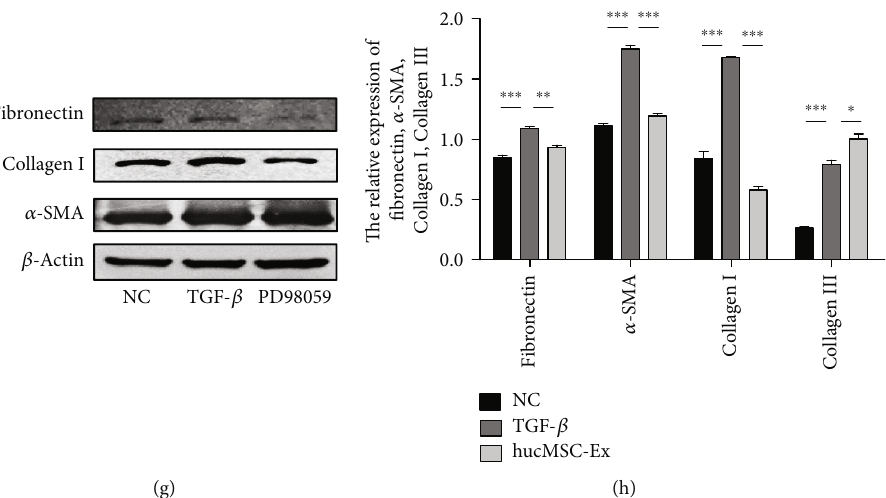
Figure 6: hucMSC-Ex inhibits the expression of fi brosis-related molecules by inhibiting ERK phosphorylation. (a) Western blot analysis of ERK expression in DSS-induced IBD-associated fi brosis in mice. (b) Grayscale scanning of (a), ∗∗∗ P < 0 : 001 . (c) Western blot analysis of ERK expression in human intestinal fi broblasts CCD-18Co after treatment with TGF- β or hucMSC-Ex for 48 hours. (d) Grayscale scanning of (c), ∗∗∗ P < 0 : 001 . (e) The expressions of t-ERK and p-ERK. (f) Grayscale scanning of (e), ∗∗∗ P < 0 : 001 . (g) The expressions of α -SMA, collagen I, and fi bronectin. (h) Grayscale scanning of (g), ∗∗ P < 0 : 01 and ∗∗∗ P < 0 : 001